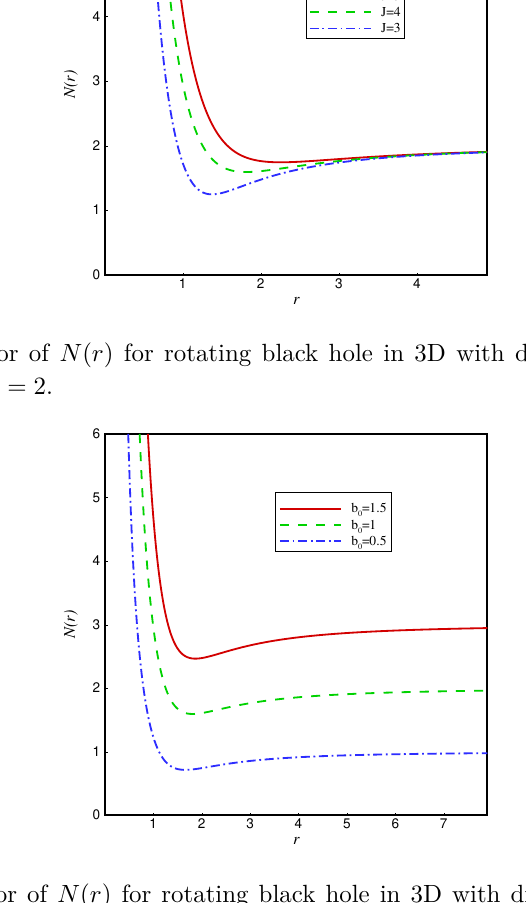
Figure 8 . The behavior of N ( r ) for rotating black hole in 3D with different b 0 , where we have taken l = 1 , J = 4 and M = 2